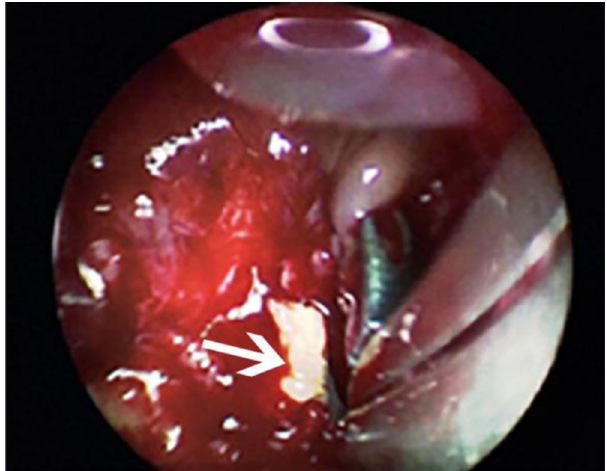
Fig 5. Endoscopic image showing the root of 25 taken from inside the left maxillary sinus (arrow).